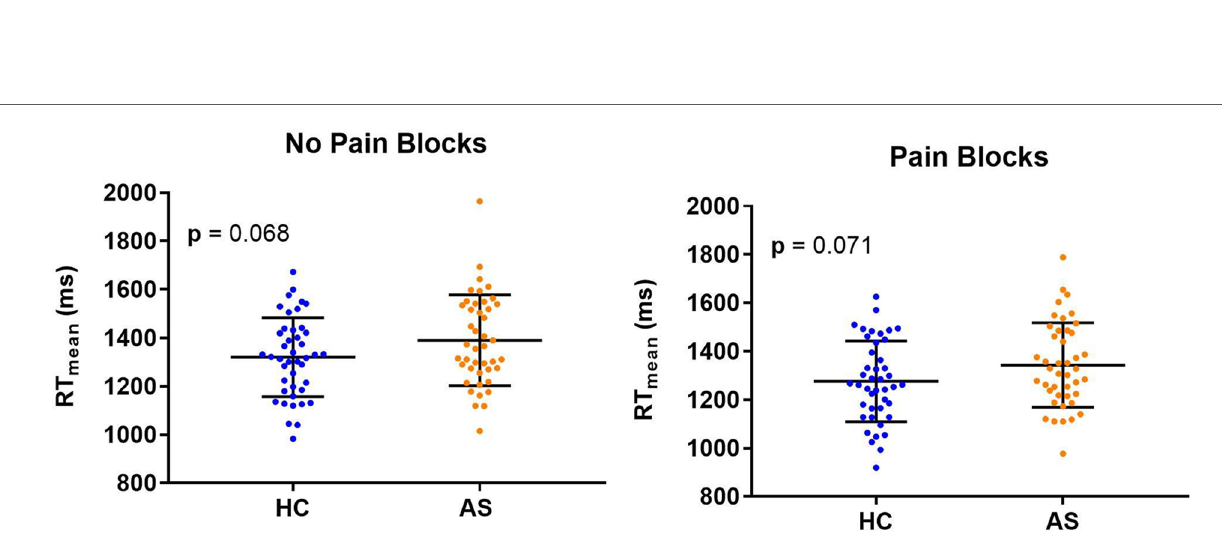
FIGURE 2 Individual and mean group task reaction times (RTs) for the healthy controls (HCs) and the ankylosing spondylitis (AS) group. Individual HCs are represented by the blue dots and individuals in the AS group are represented by the orange